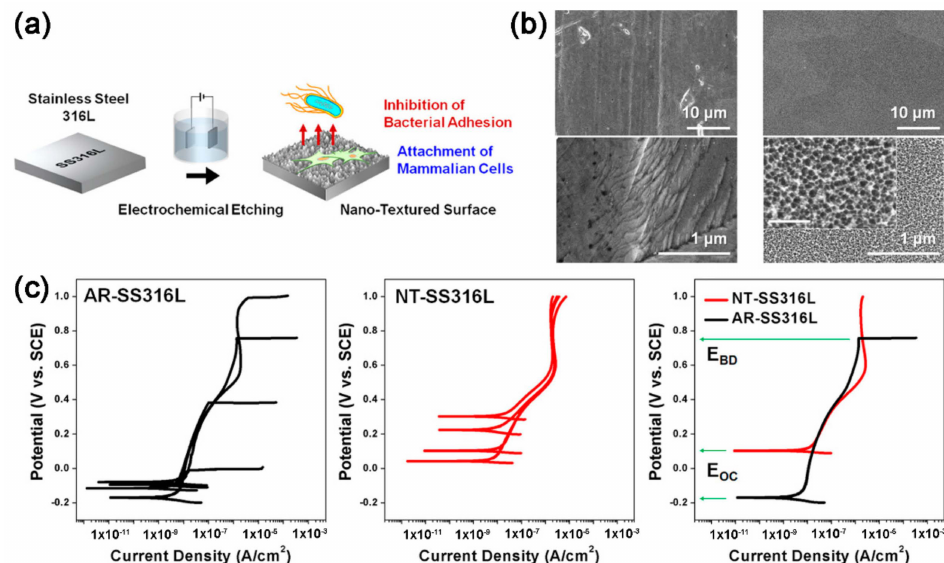
Figure 12. ( a ) Scheme of electrochemical etching method. ( b ) Surface morphologies of AR-SS316L and NT-SS316L surfaces. The scale bar of the inset image is 200 nm. ( c ) Potentiodynamic polarization curves of AR-SS316L and NT-SS316L specimens in Hank’s balanced salt solution. Reprinted from [80]. Copyright (2017), with permission from American Chemical